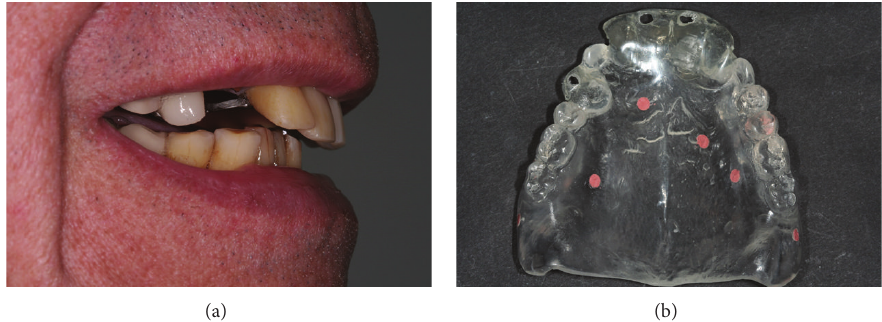
Figure 1: (a) Preoperative view demonstrating failing maxillary dentition. The treatment plan includes immediate implants in combination with CAD-CAM technology and their immediate loading with a prefabricated fixed prosthesis. (b) A radiographic template is realized according to the protocol for partially edentulous patient: verification windows to assess correct seating of radiographic template and radiopaque markers placed below gingival plane.